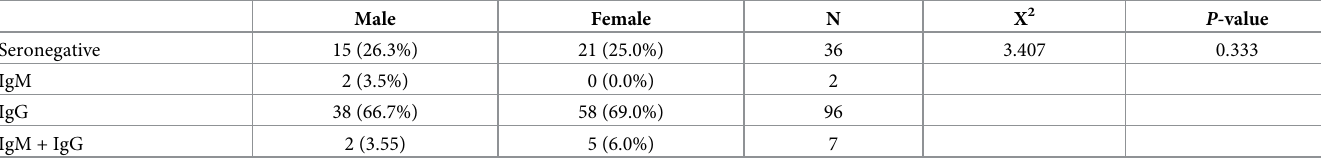
Table 5. Association between seropositivity and